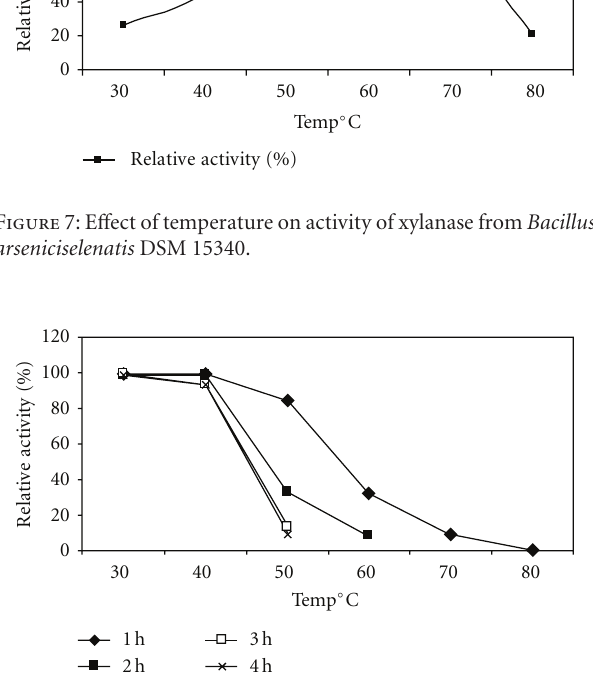
Figure 8: E ff ect of temperature on stability of xylanase from Bacil- lus arseniciselenatis DSM